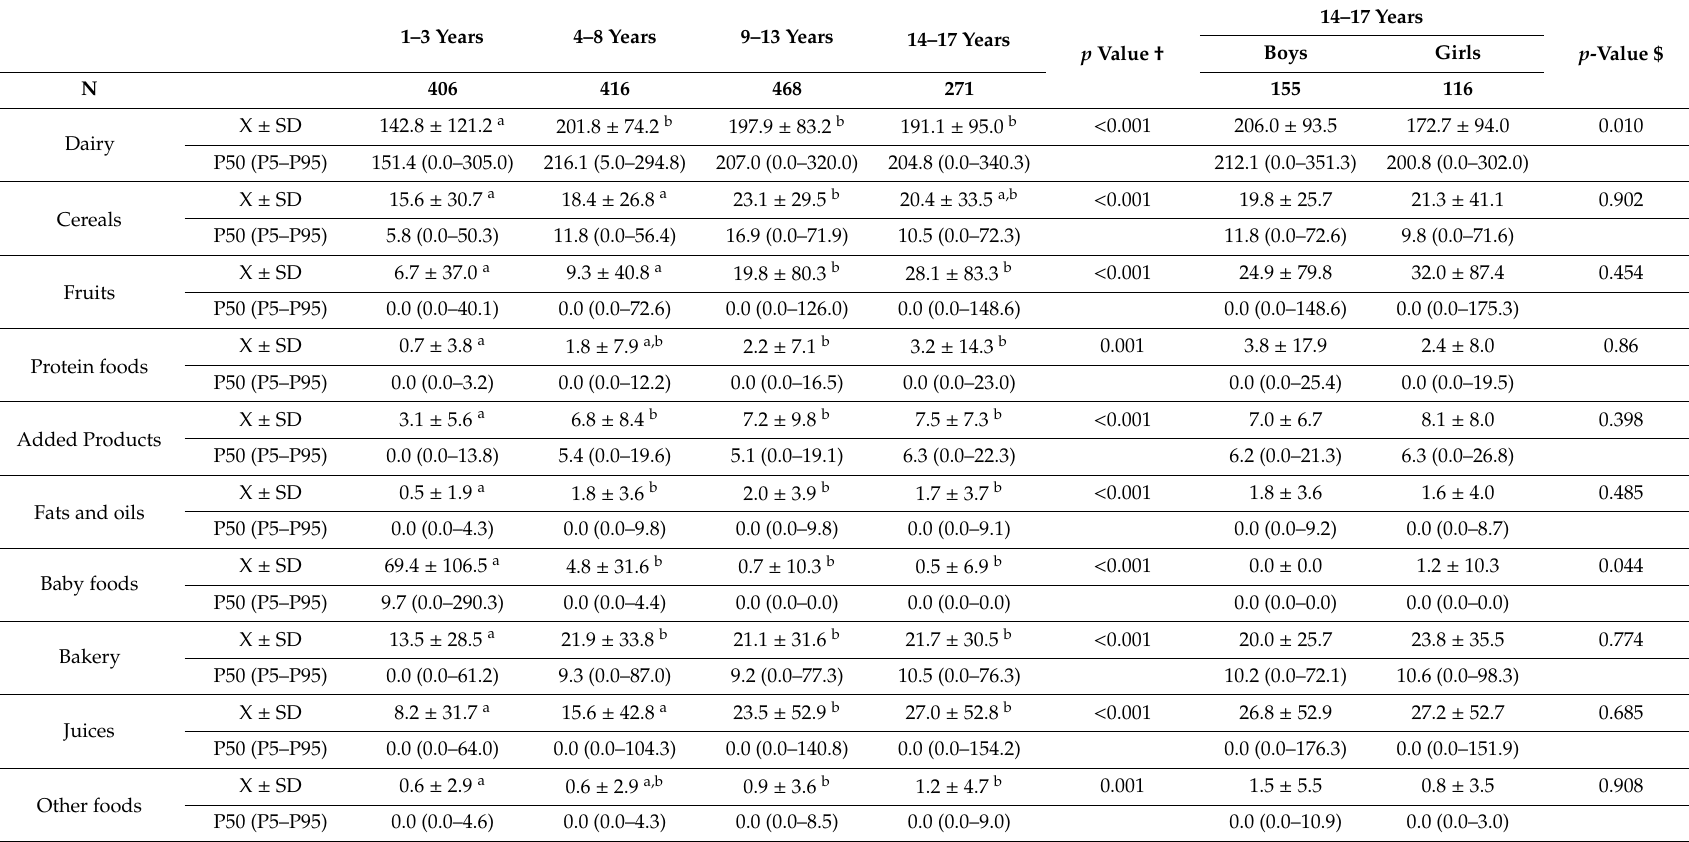
Table 2. Breakfast food consumption by age group (g / day adjusted by